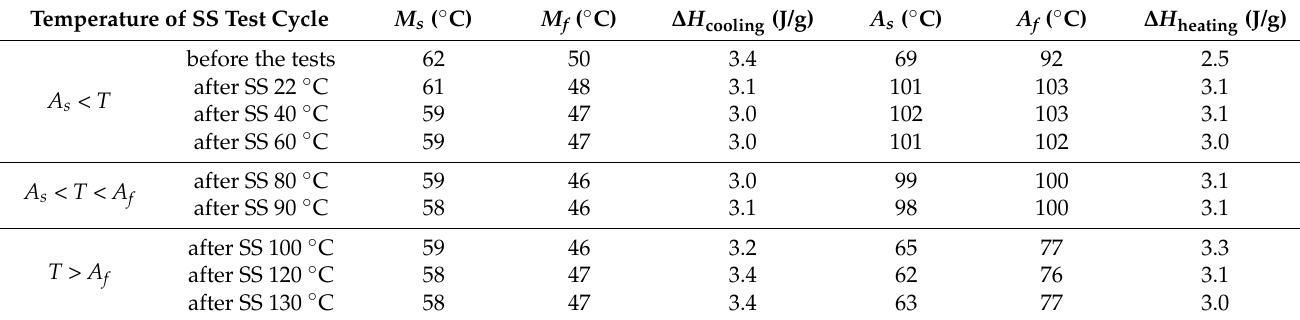
Table 1. Characteristic parameters of the martensitic transformation before the compression tests and after the load- ing/unloading stress–strain (SS) cycles at different temperatures determined by means of the calorimetric measurements. The values of the forward martensitic transformation temperature start ( M s ), finish ( M f ) and enthalpy change ( ∆ H cooling ) are obtained from the cooling ramps. Reverse martensitic transformation temperature start ( A s ), finish ( A f ) and the enthalpy change ( ∆ H heating ) are extracted from the heating